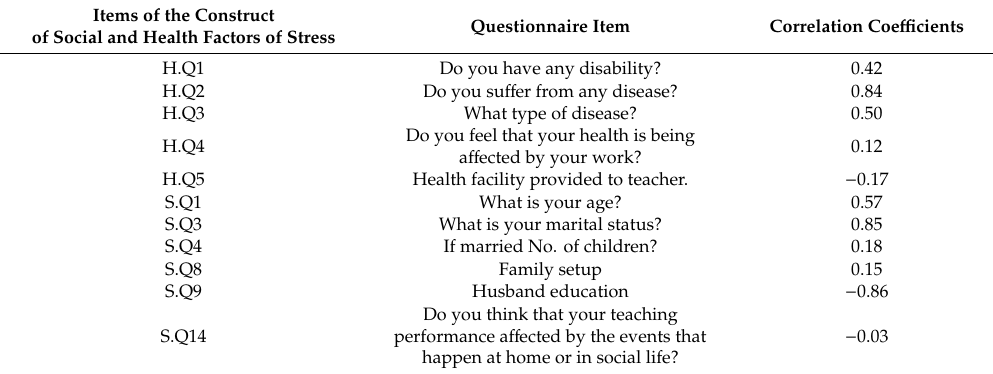
Table 17. Items of the construct of social and health factors of stress.